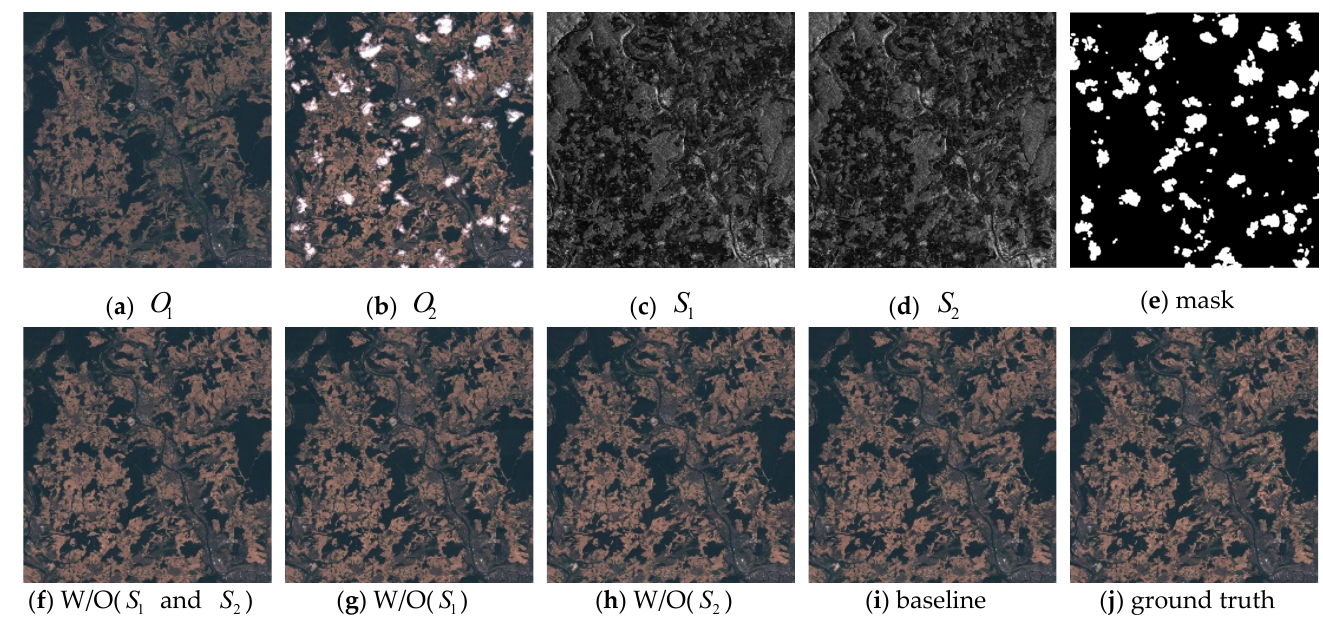
Figure 9. Simulation experiment results of ablation models.